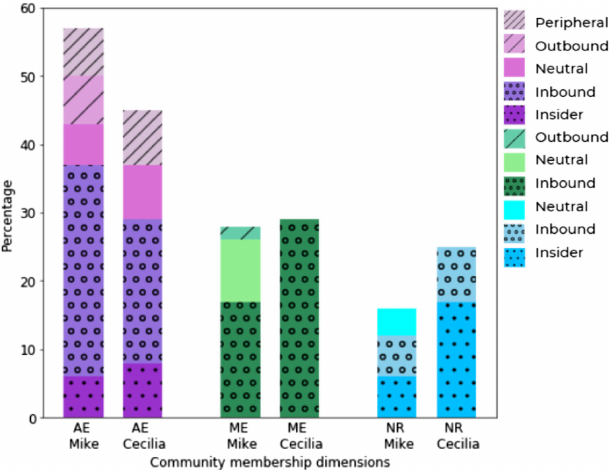
FIG. 3. Community dimensions within PCA represented as a percentage of all community membership codes for both Mike and Cecilia. The codes have been separated into the subcode categories — insider (dots), inbound (circles), neutral, outbound (diagonal), and peripheral (closely spaced diagonal) — to show the percentage of codes that were coded as movement or community membership levels. Mutuality of engagement did not produce any peripheral or insider codes and negotiation of the repertoire did not produce any outbound or peripheral codes.